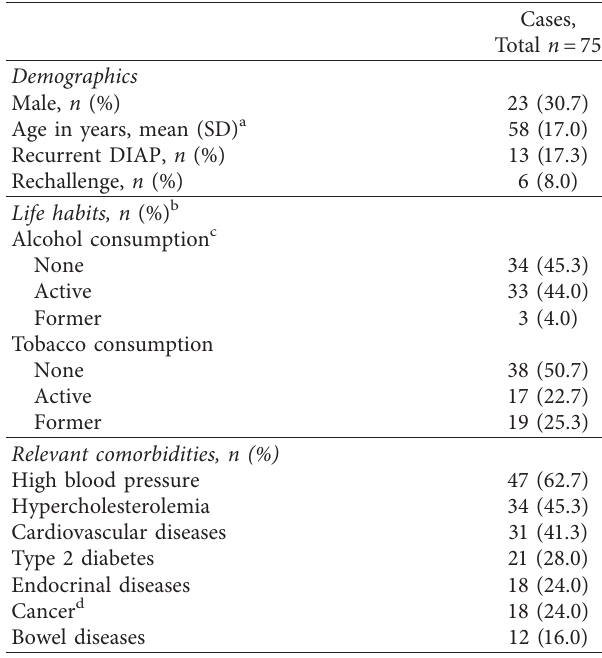
Figure 1: Schematic representation of the data sorting process. Flow chart representing the number of cases included in the study. Table 1: Characteristics of drug-induced acute pancreatitis iden- tified in the cases